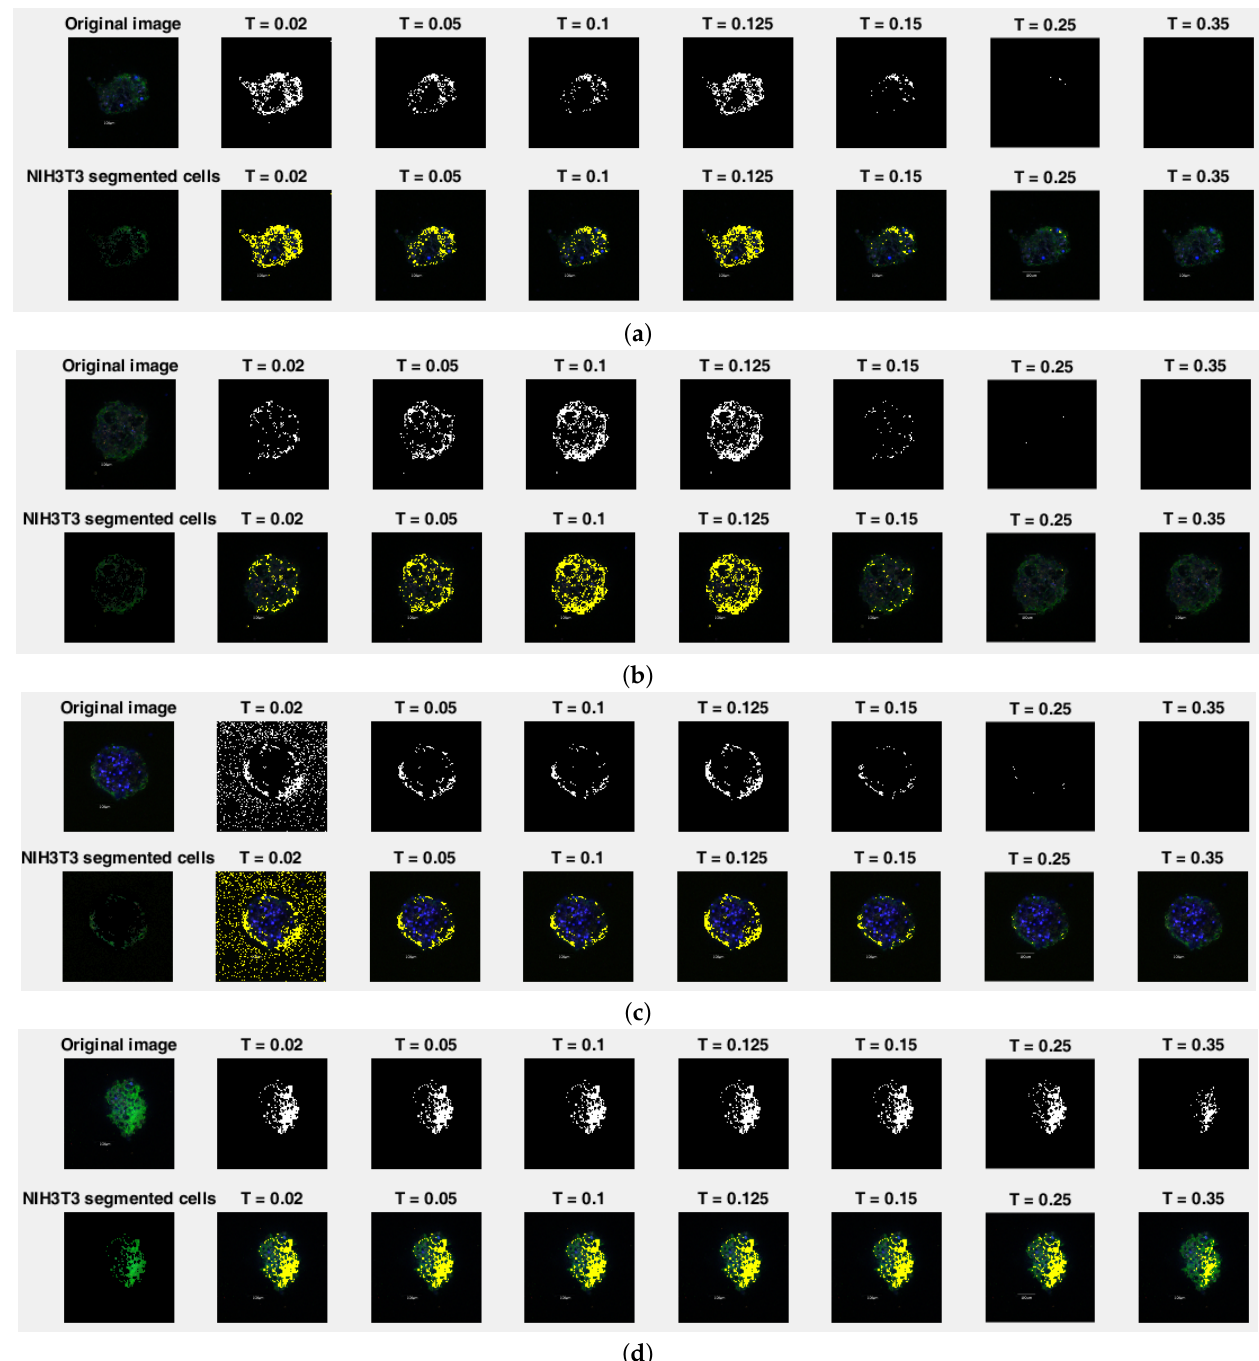
Figure 6. Optimal threshold evaluation for NIH3T3 cells using various threshold segmentation results. ( a ) 2:0.5 (2_05_ z 12), ( b ) 2:1 (2_1_ z 14), ( c ) 2:2 (2_2_ z 17), and ( d ) 2:4 (2_4_ z 10) ratio